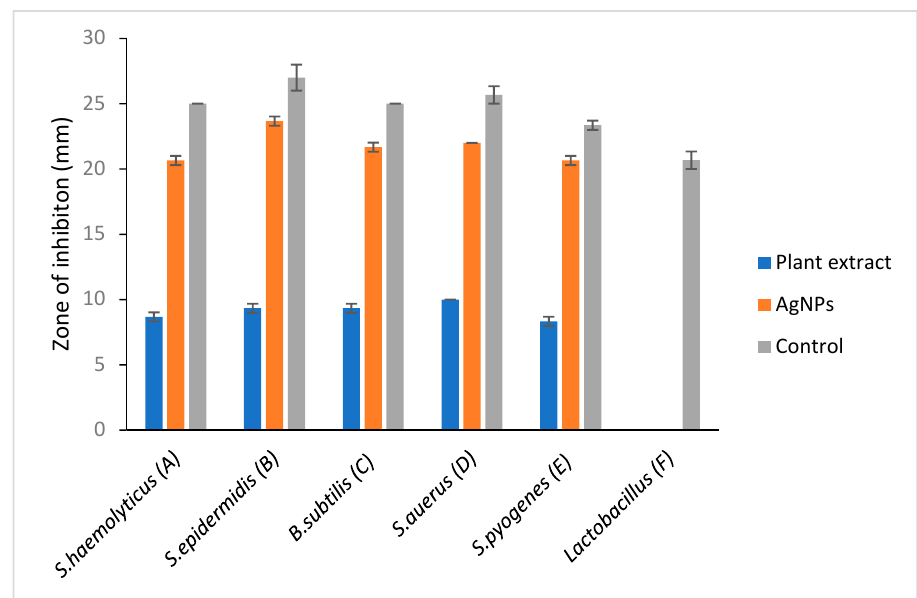
Figure 5. Antimicrobial analysis against selected Gram-positive bacteria. A: Staphylococcus haemolyticus , B: Staphylococcus epidermidis , C: Bacillus subtilis , D: Staphylococcus aureus , E: Streptococcus pyogens , F: Lactobacillus . Comparative evaluation of selected Gram-positive bacteria vs. zone of inhibition.